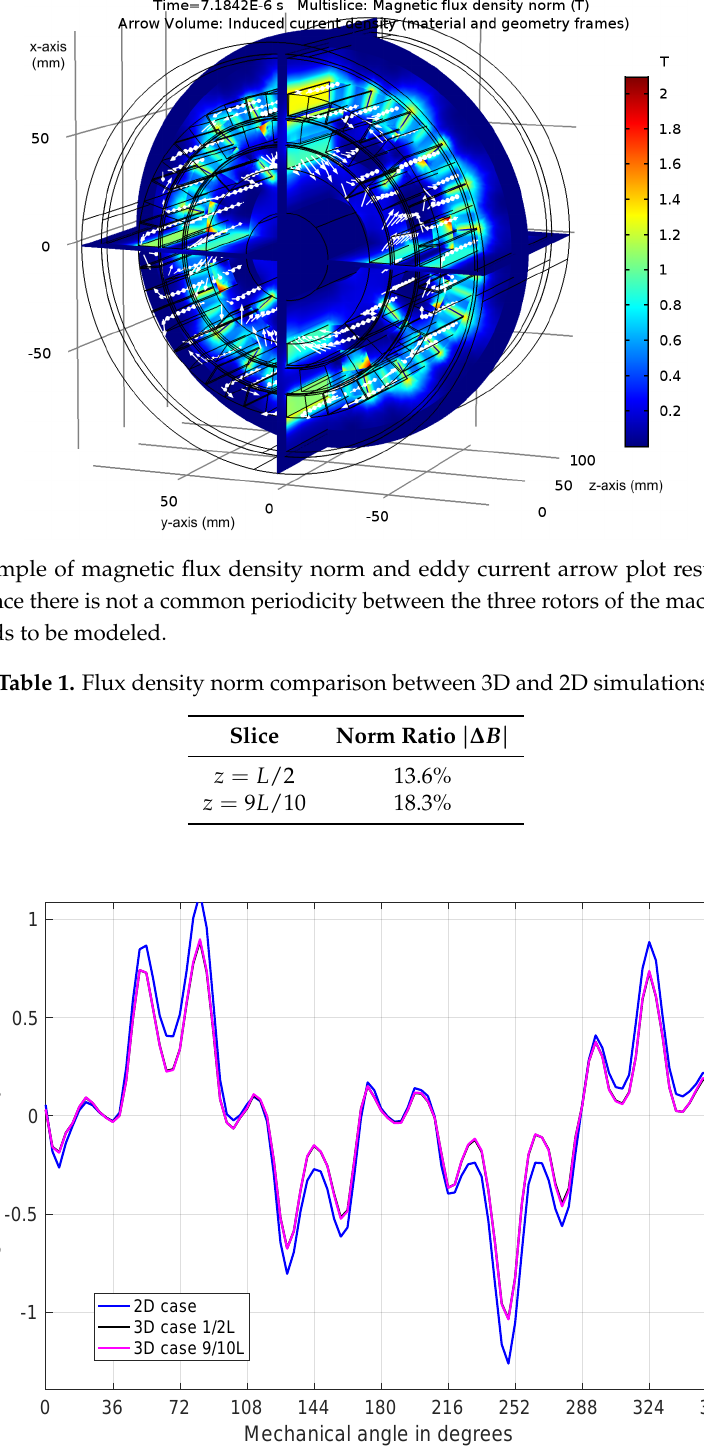
Figure 3. Comparison of B x ( r = 86.3 mm, angle = 0–360 ◦ ) between 2D and 3D simulations (outer rotor). The flux density waveforms of the 3D case (magenta and black lines) are exactly